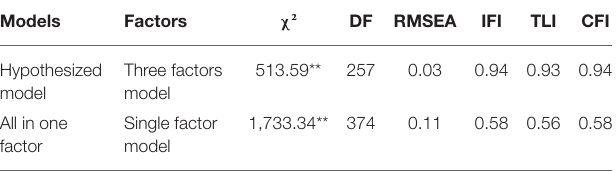
TABLE 3 | Confirmatory factor analysis (CFA).